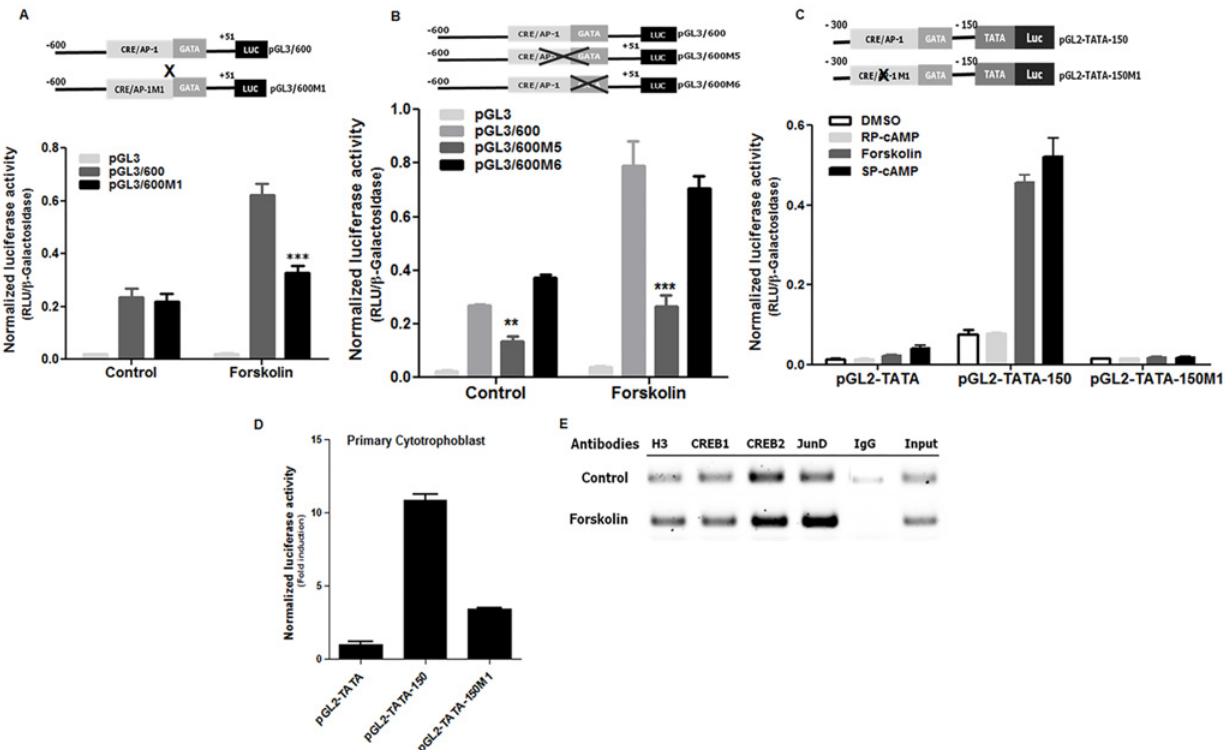
Fig 4. Importance of the CRE/AP-1-like motif in induced Syncytin-2 promoter activity. (A-C) BeWo cells were co-transfected with pGL3/600 (400 ng) or equivalent constructs bearing the M1 ( A ), M5 or M6 ( B ) mutant sequences along with pRcActin-LacZ (200 ng). In C , BeWo cells were co-transfected with pGL2-TATA-150 or pGL2-TATA-150M1 (vs. the control pGL2-TATA vector) (400 ng) along with pRcActin-LacZ (200 ng). Following transfection, cells were left untreated (Control or DMSO) or treated with forskolin ( A-C ) and RP-cAMP/SP-cAMP ( C ) for 12 h. ( D ) Primary villous cytotrophoblasts were microporated with pGL2-TATA-150 or pGL2-TATA-150M1 (vs. the control pGL2-TATA vector) (400 ng) along with pRcActin-LacZ (100 ng). Cells were then harvested and analyzed for luciferase expression. Luciferase values were normalized for β -galactosidase activity and are expressed as the mean normalized RLU ± S.E.M. from three independently transfected cells in the same experiment. Results in ( D ) are shown as mean of fold induction over pGL2-TATA-transfected cells (set as 1) and are representative of three independent experiments ( ** p < 0.01; *** p < 0.001). ( E ) Chromatin immunoprecipitation analysis of CREB1, CREB2 and JunD binding to Syncytin-2 promoter region in non-treated or treated BeWo cells was performed with antibodies specific to these factors or against Histone 3 (positive control) or with non-specific IgG antibodies (IgG: negative control). The-300/-150 region of the Syncytin-2 promoter was next PCR amplified on immunoprecipitated DNA. Input DNA was similarly amplified for